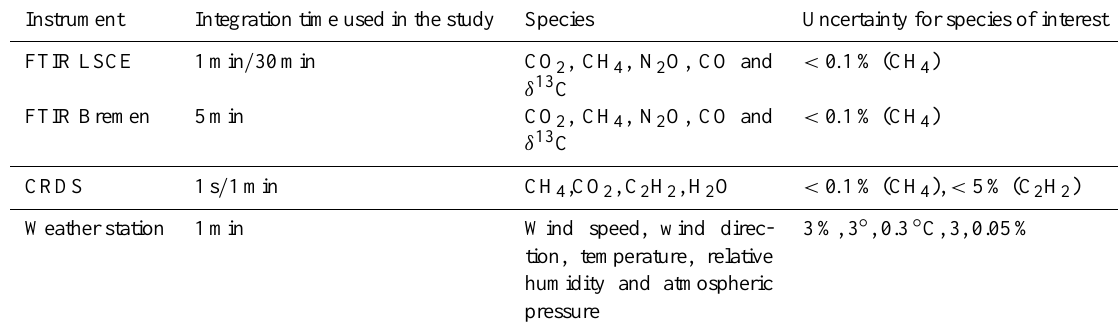
Table 1. Instruments used during the campaign and their specifications. Instrument Integration time used in the study